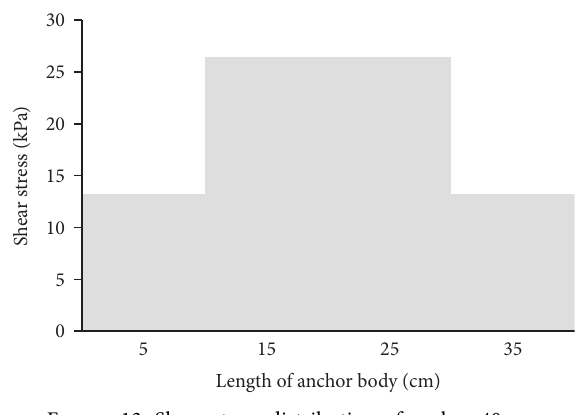
Figure 13: Shear stress distribution of anchor 40cm.